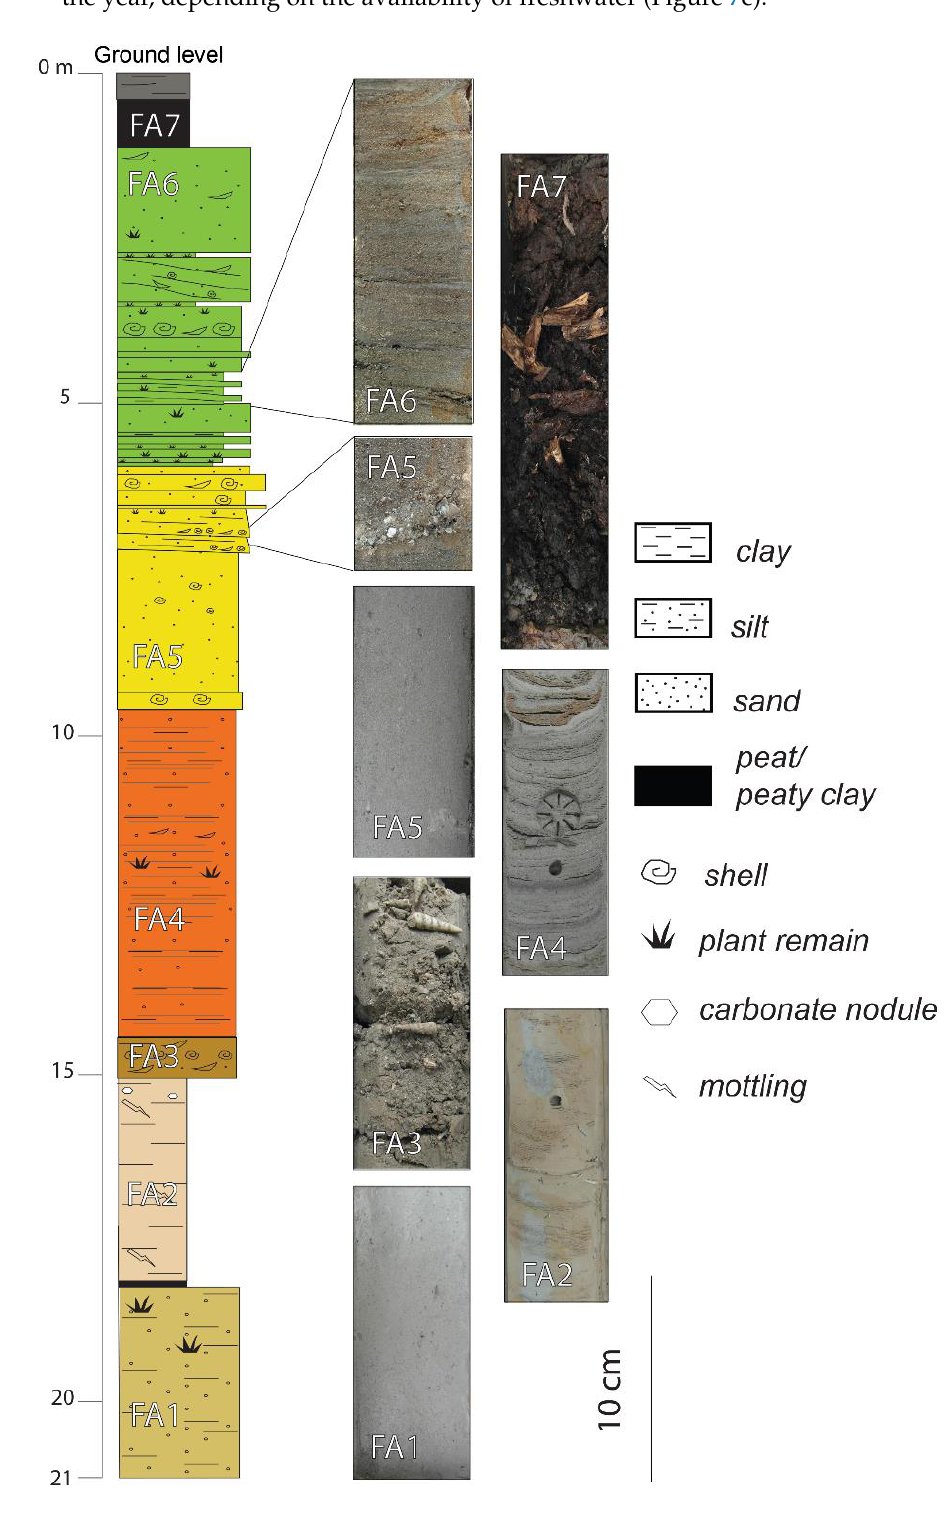
Figure 2. Stratigraphic column representative of the studied succession and images of each facies association described in the text. The section schematizes the general stratigraphy of the area, and it is not linked to any particular core. The 10 cm scale refers to the core pictures on the right of the figure.